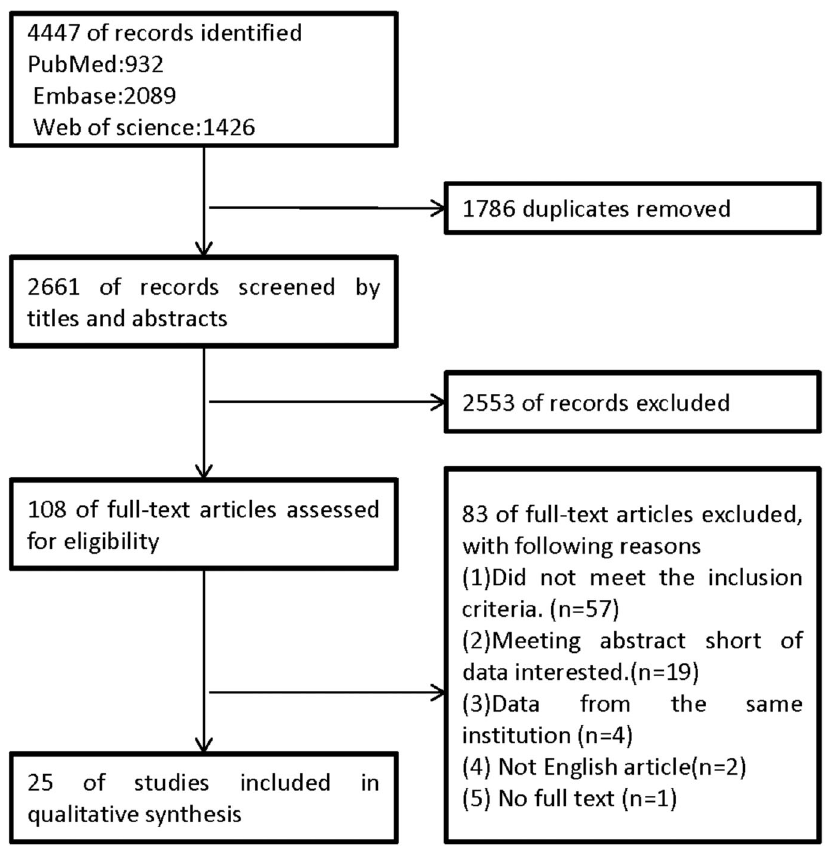
Figure 1. A flow chart highlighting study selection.